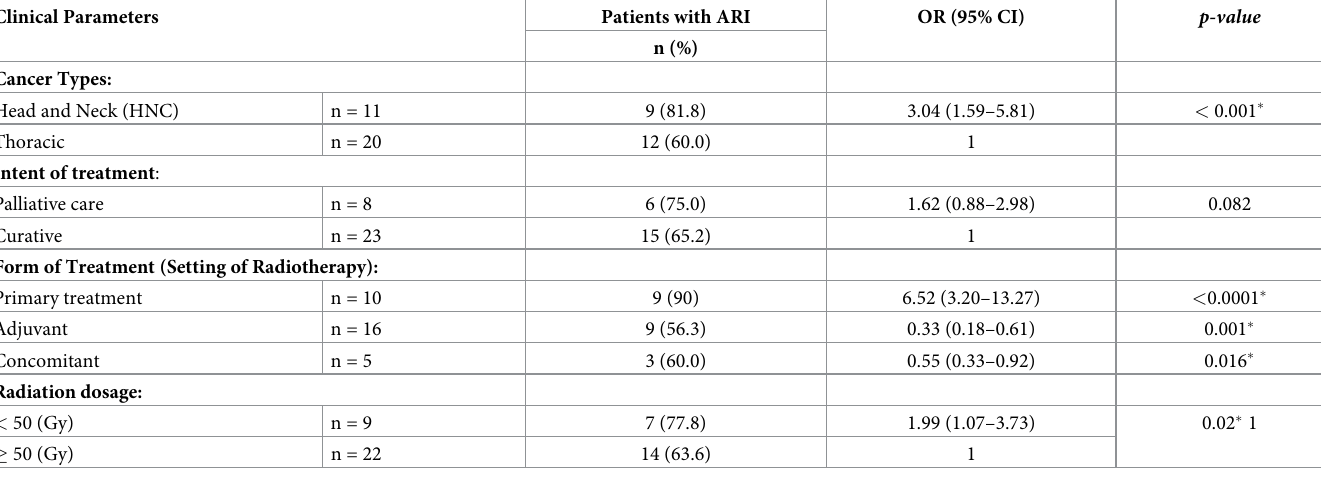
Table 5. Association of ARI with cancer type, treatment options and dosage of radiation. Clinical Parameters